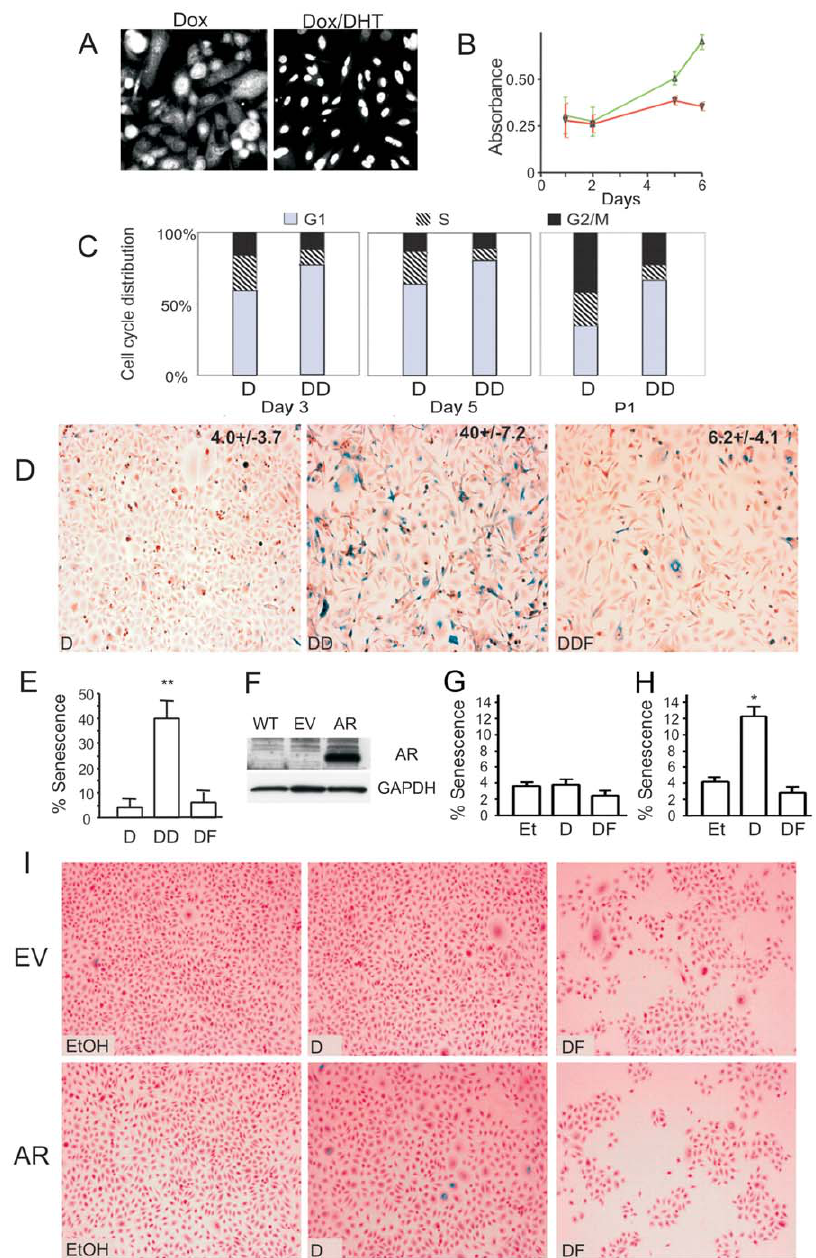
Figure 1. AR activation causes cell cycle arrest and senescence in PC3 cells. AR activation causes cell cycle arrest and senescence in PC3 cells. ( A ) In situ immunofluorescence with anti-AR antibody: note diffuse AR staining in control treated PC3-AR cells (left) and nuclear translocation on 3 day of DHT treatment (right). ( B ) Time-dependent inhibition of cell growth in vitro. PC-3 cells were cultured in Dox 6 DHT; viable cells were measured using WST-1 reagent. Each time point represents mean 6 standard deviation of three independent experiments. The difference between DHT treatment (red) and control EtOH (green) is statistically significant on day 5 (P , 0.01). ( C ) Cell cycle analysis: the cells were grown in Dox, in the absence (D) and in the presence of DHT (DD) for 3 and 5 days; after 7 days the cells were passed (P1) and incubated for another 5 days. Cell cycle distribution was analyzed by flow cytometry. Note increased cell number in Go/G1 phase accompanied by decreased in S and G2/M populations in DHT-treated cells (DD) compared to Dox alone (D). ( D ) PC3-AR cells were cultured in Dox and treated with DHT 6 Flutamide (Fl, 20 m M). After five days senescence was measured using SA- b Gal assay. Note increased b Gal positivity upon AR activation and the lack of senescence in the presence of Fl. ( E ) Senescent cells were counted on the digital images of 5 random fields using Image Tool 3.00 software (UTHSCSA); means of three independent experiments with S.D.M. are shown. ( F ) RWPE-1 cells were transfected with control lentivirus or lentiviral vector encoding AR. AR expression was measured in whole cell lysates by Western blot. GAPDH antibody was used to assess loading. ( G, H ) RWPE-AR and vector transfected (RWPE-C) cells were cultured in DHT, DHT and Flutamide (Fl) or with equal volume of EtOH added as control. Senescence was assessed with SA- b Gal assay (I) and quantified as in (E).